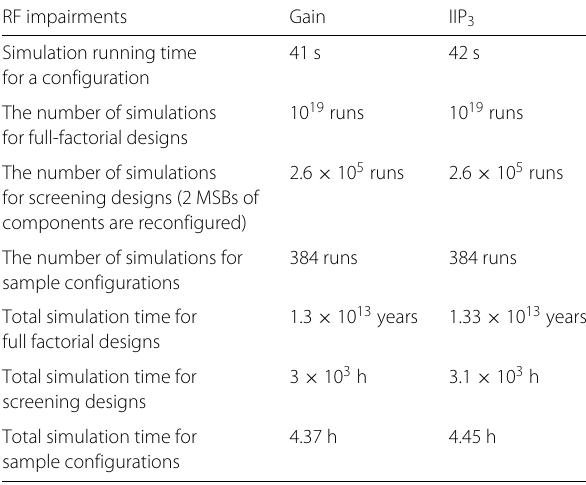
Table 1 Comparison of time consumption for RF impairment